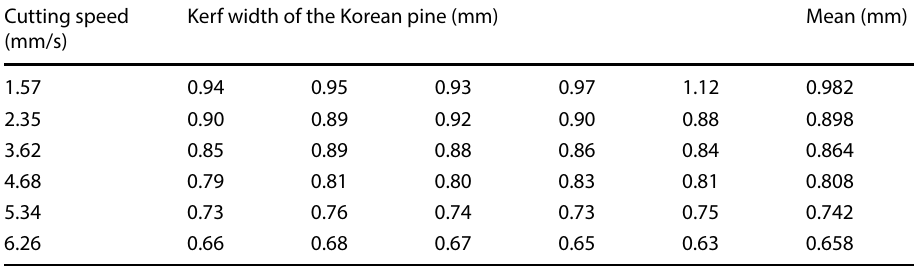
Table 13 Kerf width data of Korean pine ( Pinus Koraiensis ) under M